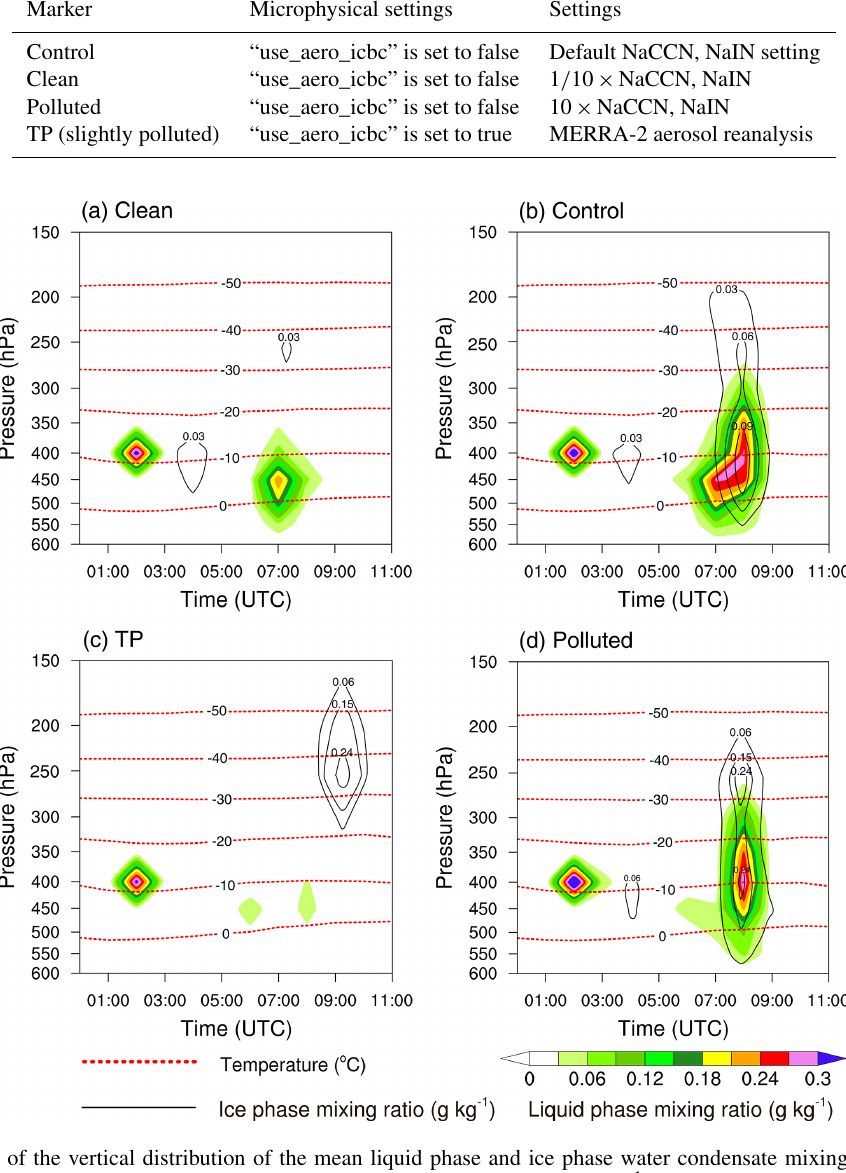
Figure 6. Time series of the vertical distribution of the mean liquid phase and ice phase water condensate mixing ratio in (a) clean, (b) control, (c) TP, and (d) polluted simulations in area A (31.4–31.5 ◦ N, 92.0–92.1 ◦ E), in gkg − 1 , with dashed red lines as